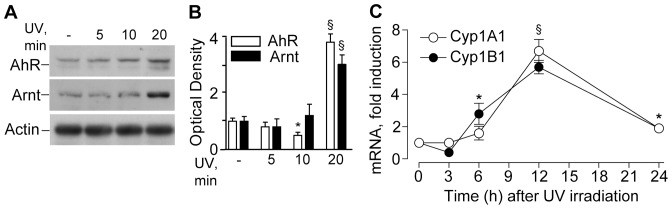
Time-dependent effects of UV irradiation on metabolic system in NHEK.
A. Time-dependent effects on nuclear levels of AhR and Arnt post-UV irradiation. Actin was used as a loading control; B. Densitometry of western blot bands of AhR and Arnt in the nucleus; *P<0.05 and §P<0.01 versus untreated controls (-). C. Time-course of CYP1A1 and CYP1B1 transcripts post-irradiation; *P<0.05 and §P<0.01 versus untreated controls (0 h). Significance refers to both the transcripts at each time-point. The results are representative of three independent experiments.